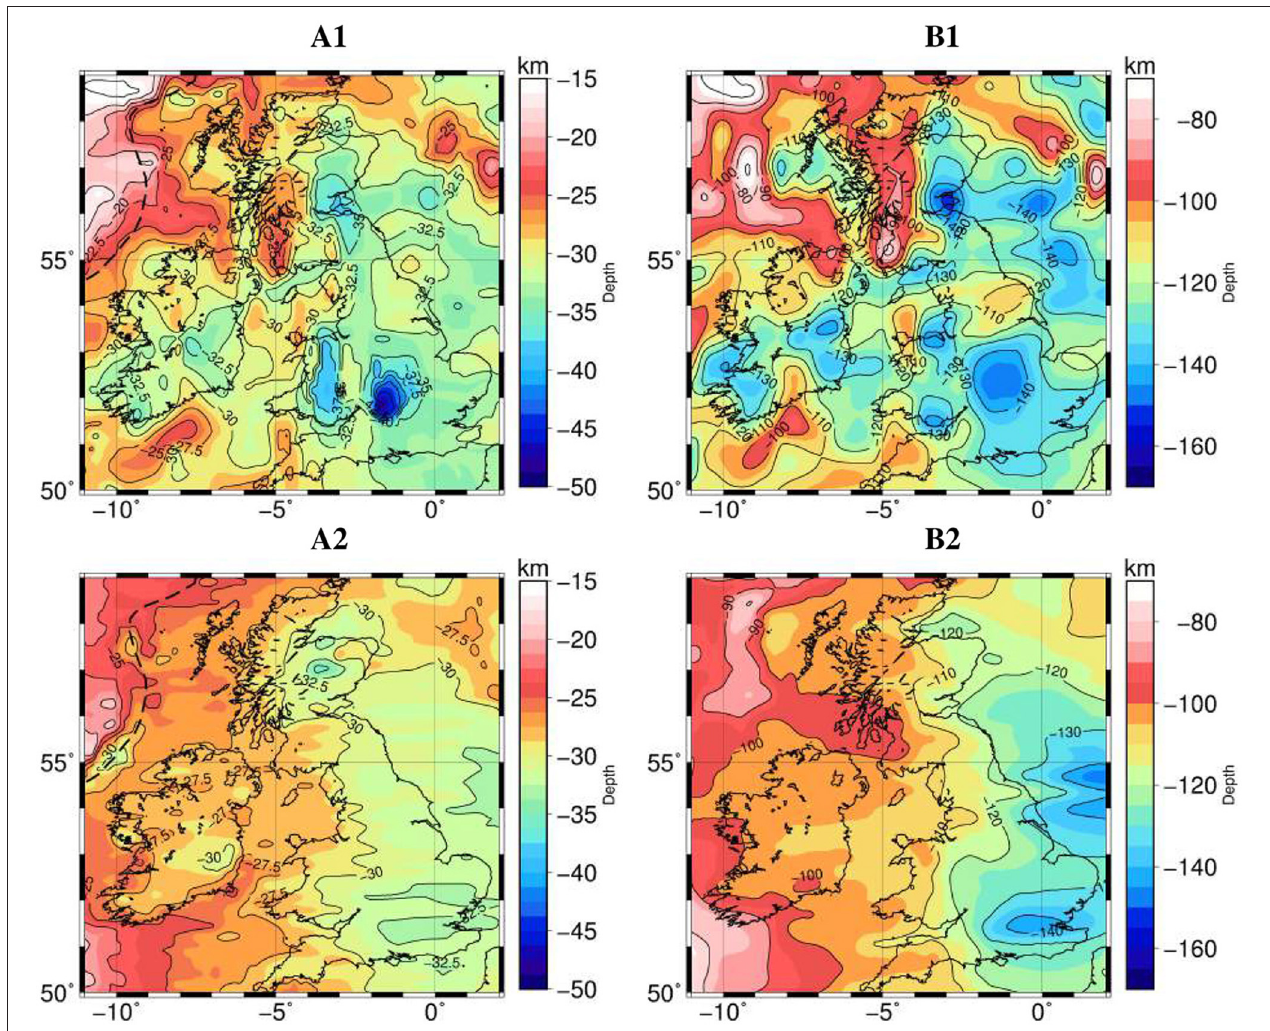
FIGURE 5 | Moho and Lithosphere-Asthenosphere boundary of our end-member lithospheric models. (A) Moho depth. Isolines every 2.5 km. (B) Lithosphere-Asthenosphere boundary depth. Isolines every 10 km. First row corresponds to model M1_s (A1, B1) , second row corresponds to model M2_g-elev (A2, B2) . The dashed line in (A1,A2) indicates the boundary between oceanic and continental crustal